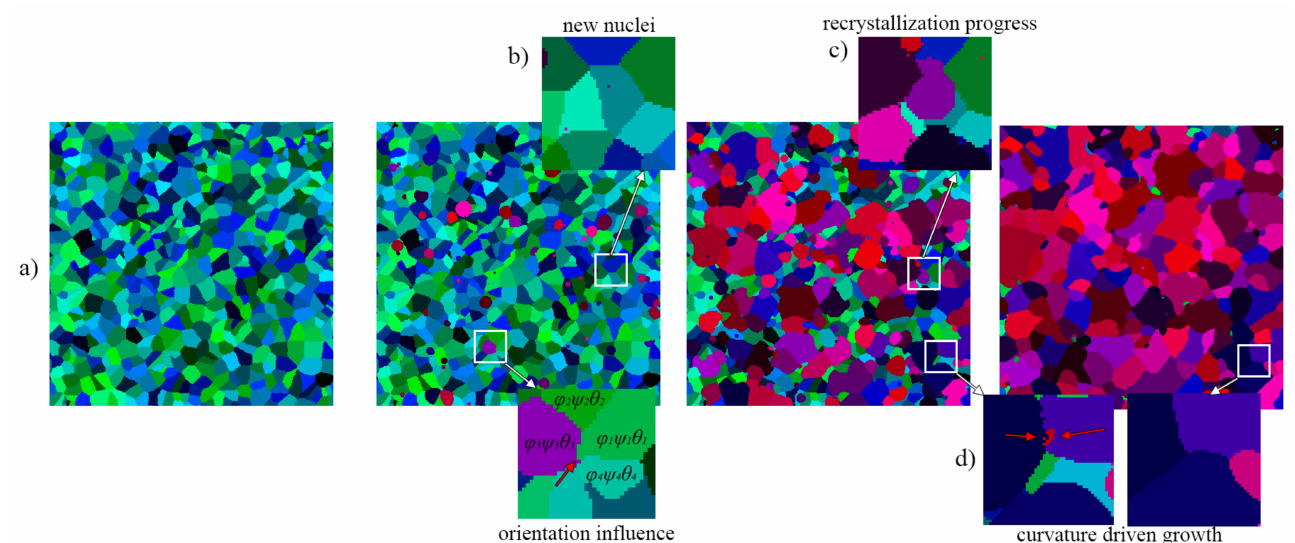
Figure 1. Examples of results from the CA-SRX model ( a ) initial microstructure, ( b ) nucleation stage, ( c ) recrystallization progress, and ( d ) grain growth after recrystallization (red palette represent recrystallized